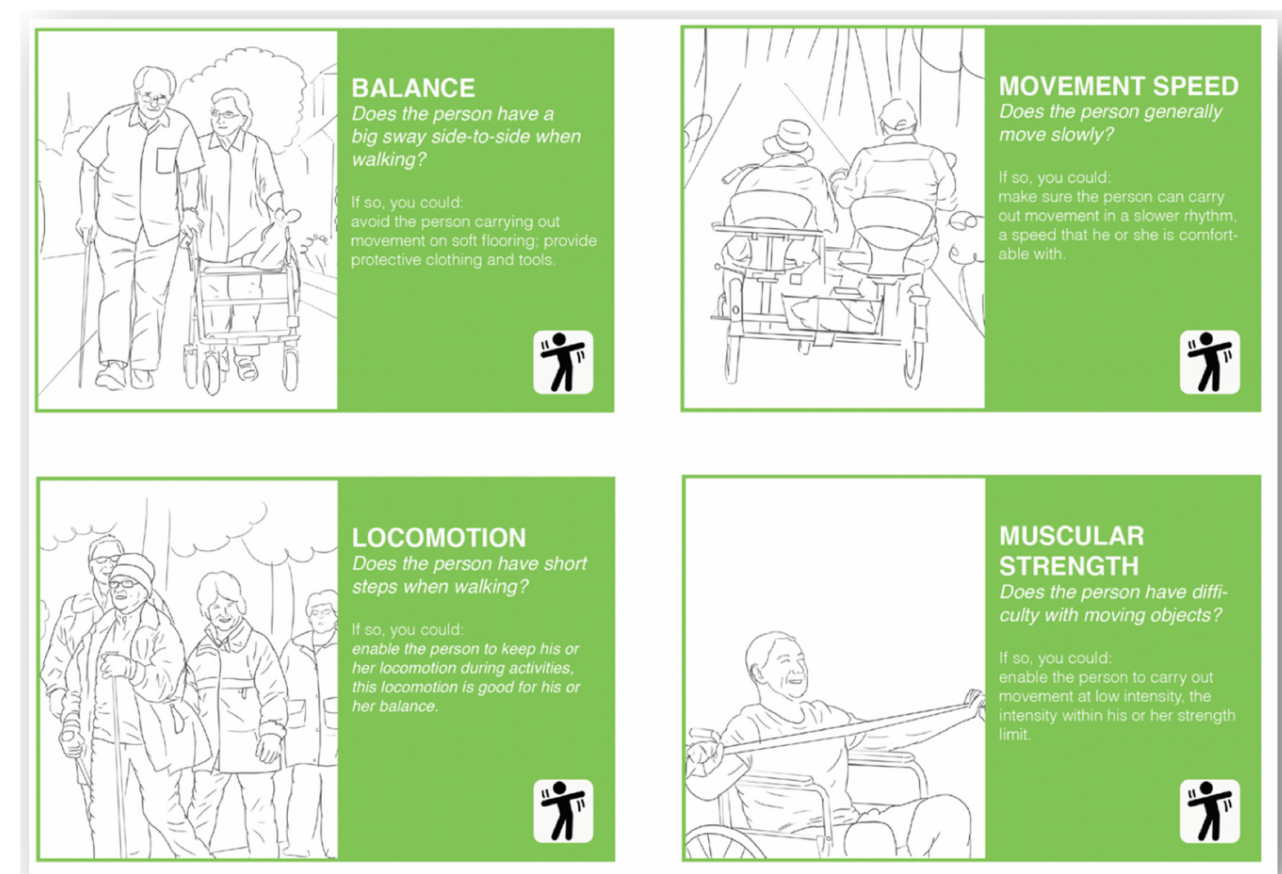
Figure 4. The cards for movement-oriented